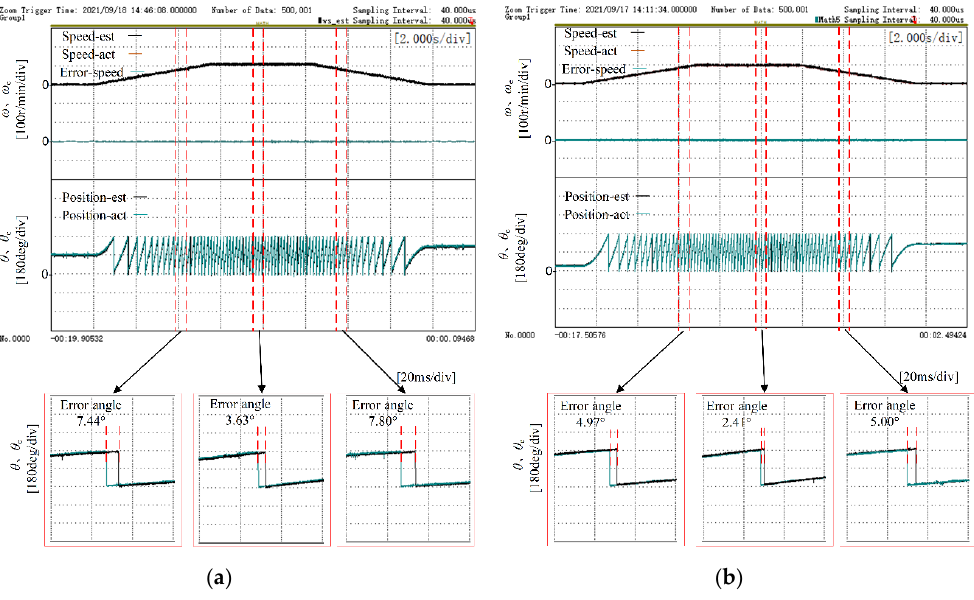
Figure 14. The speed control of dynamometer with traditional method and the proposed method from 0 r/min to 100 r/min, and from 100 r/min to 0 r/min: ( a ) traditional method; ( b ) the proposed method.